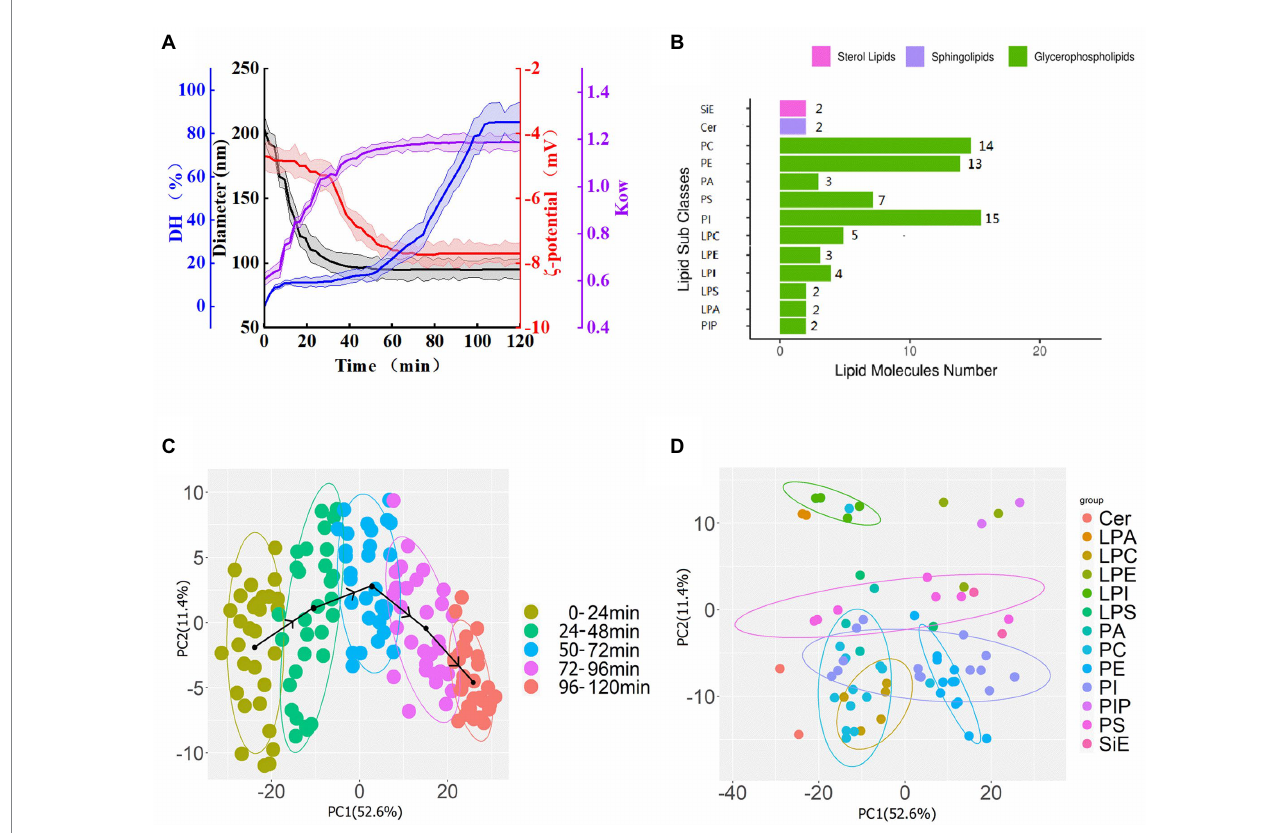
FIGURE 1 (A) Changes of the diameter of nano-Fe 3 O 4 @TLP- PCN (black line), the degree of hydrolysis of protein corona (blue line), ζ -potentials (red line), and surface hydrophobicity (violet line) during PCN proteolysis process. (B) 13 membrane lipids subclass and 72 lipid molecular species. (C) PCA score plot of membrane lipids colored by samples which were divided into a group every 24 min of proteolysi time. (D) PCA loading plot of membrane lipid